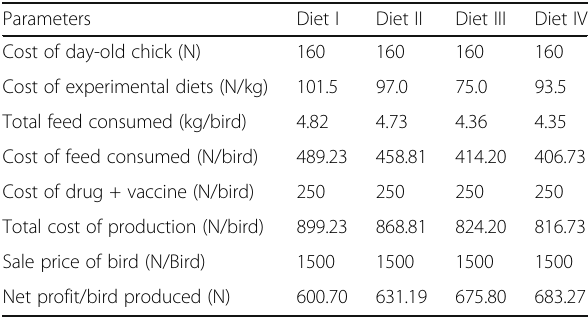
Table 9 Economics of broiler chicken fed with diets containing graded level of fortified bread waste meals